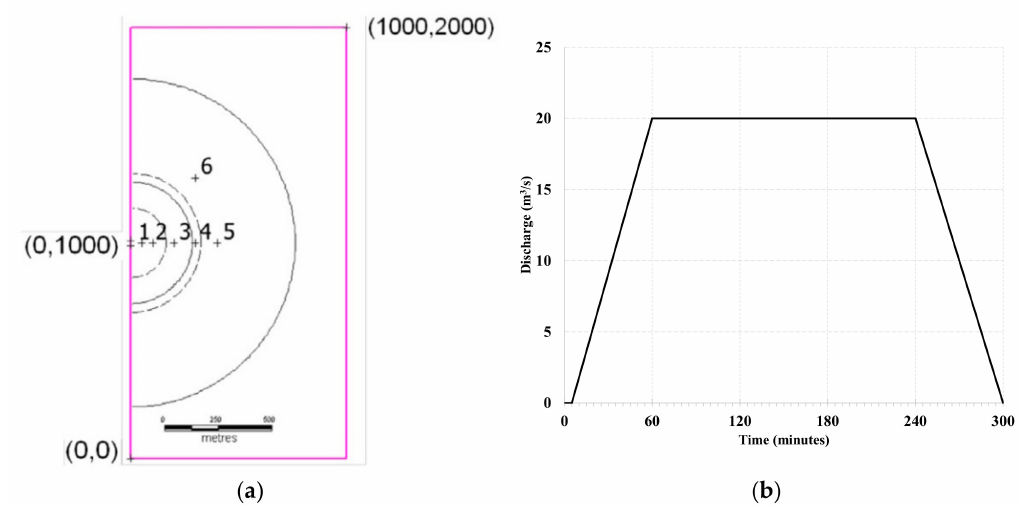
Figure 8. ( a ) EAT4 domain with 6 outpoints taken from N é elz and Pender [38] ( b ) Inflow hydrograph at the central-west point (x, y = 0 m, 1000